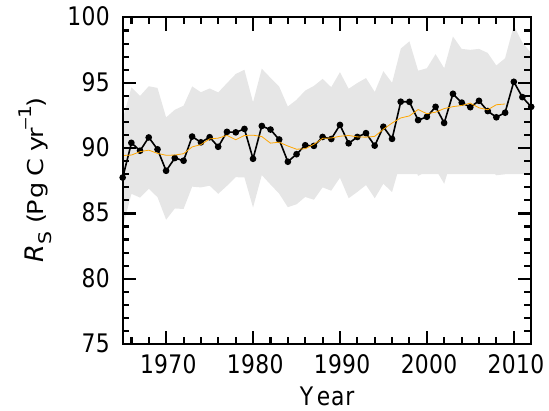
Figure 3. Temporal variation of the estimated global soil respira- tion. The grey region indicates the 95% confidence limits of the Monte Carlo simulation ( N = 1000). The orange line represents the 5-year moving